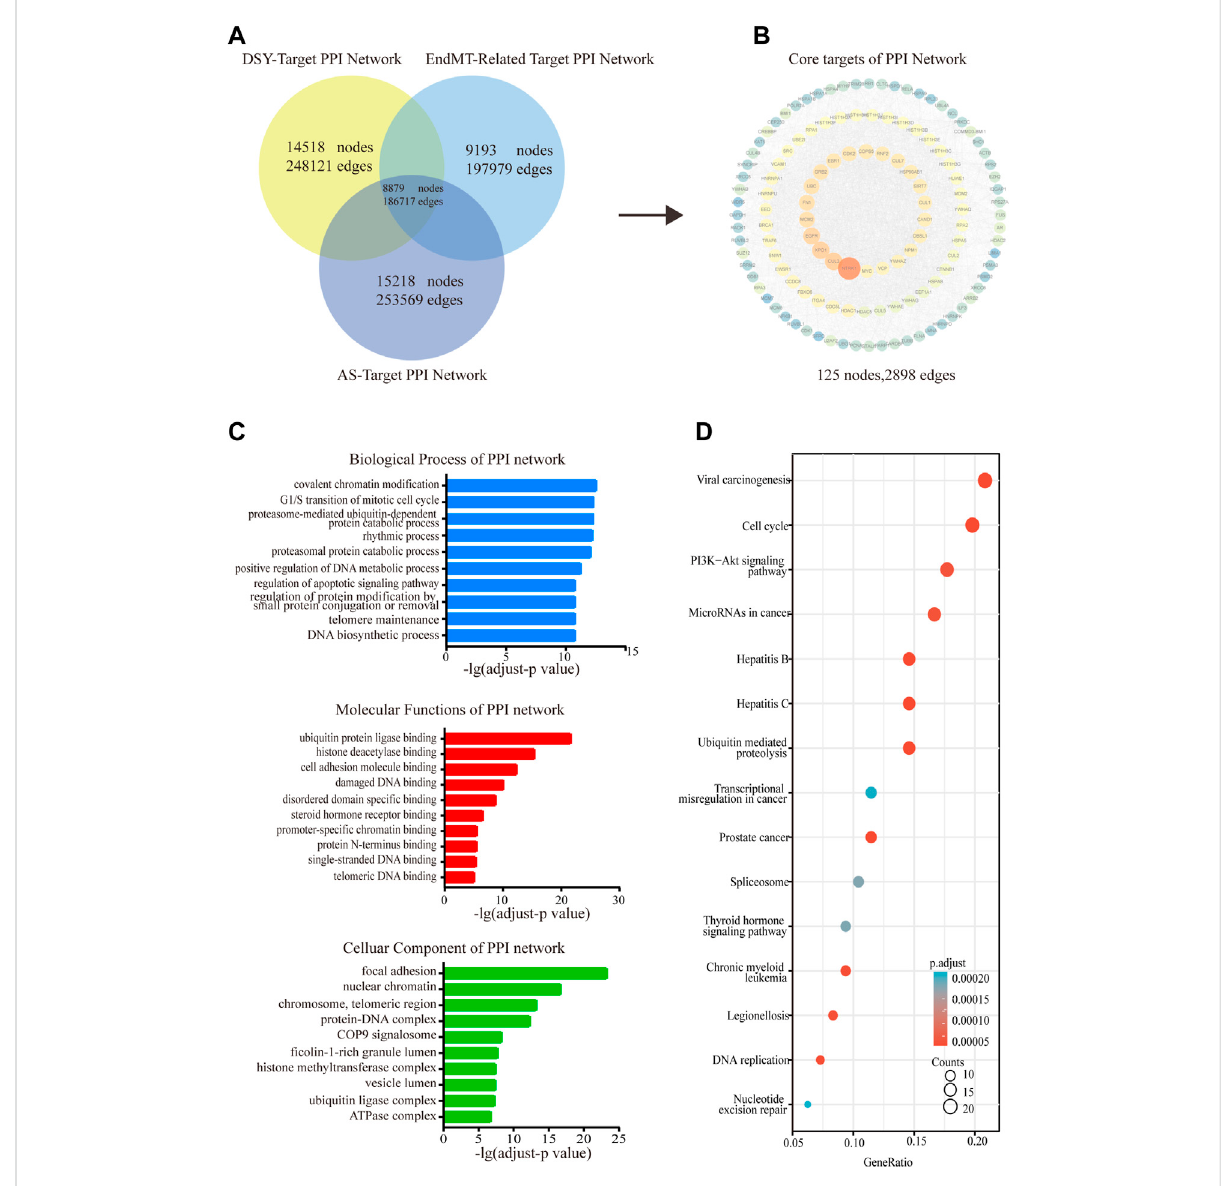
FIGURE 1 Functional enrichment analysis of the PPI network. (A) The shared targets of PPI with regard to DSY, EndMT and AS. (B) The PPI network of DSY regulatingEndMTintreatingAS. (C) GOontologyanalysisofbiologicalprocess,molecularfunctions,andcellularcomponents. (D) KEGGenrichment analysis. The X -axis indicated the counts of the target symbols in each pathway; the Y -axis represented the main pathways ( p <